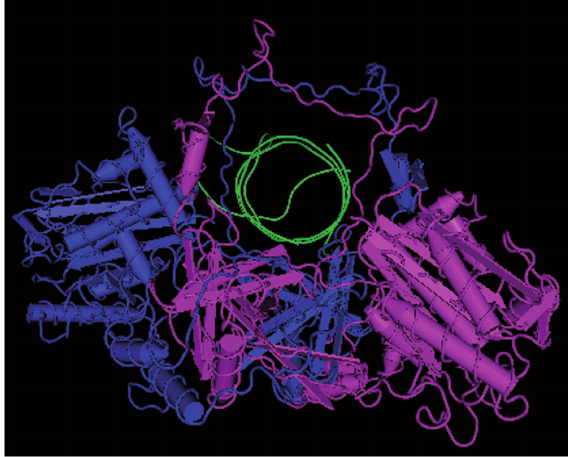
Figure 2 Crystal structure of human Ku bound to DNA. Ku70 is shown in purple, Ku80 in blue and the DNA strand in green. Reproduced with permission from Ref.